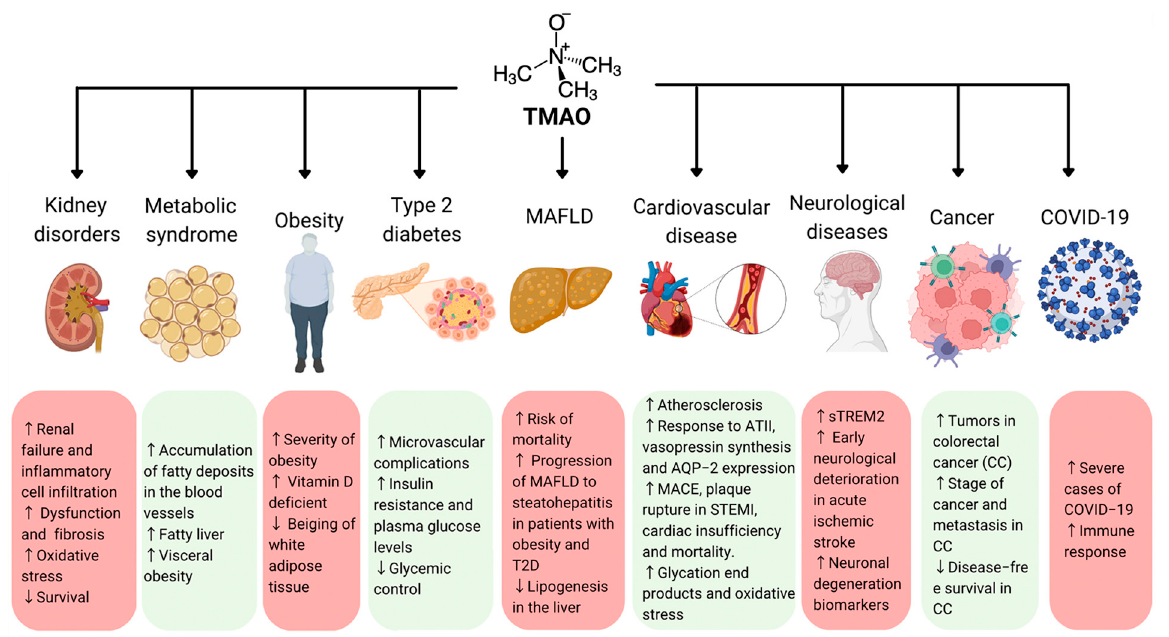
Figure 2. The role of TMAO in human health. TMAO has been associated with an enhanced immune response, which is involved in the pathogenesis of several diseases, such as cardiovascular and neurological diseases. An elevated level of TMAO has been linked to kidney disorders; metabolic syndrome; obesity; type 2 diabetes; MAFLD; cardiovascular diseases; neurological diseases; cancer; and, recently, severe cases of COVID-19. Arrows indicates increased (upper arrow) or decreased processes (lower arrow) (Created with canva.com and BioRender.com.).